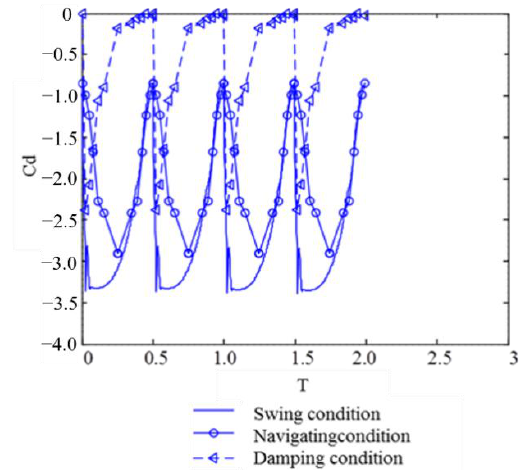
Figure 16. Damping characteristics curves.